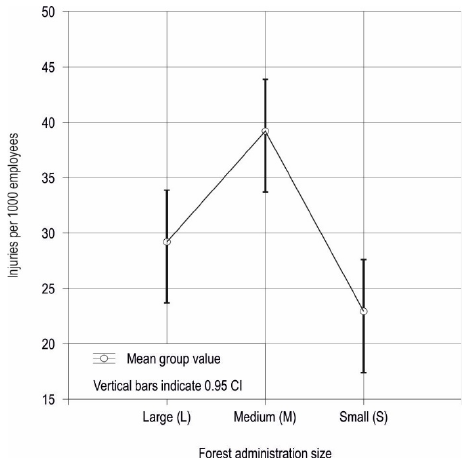
Figure 6. Mean value of injuries per 1000 employees between groups.